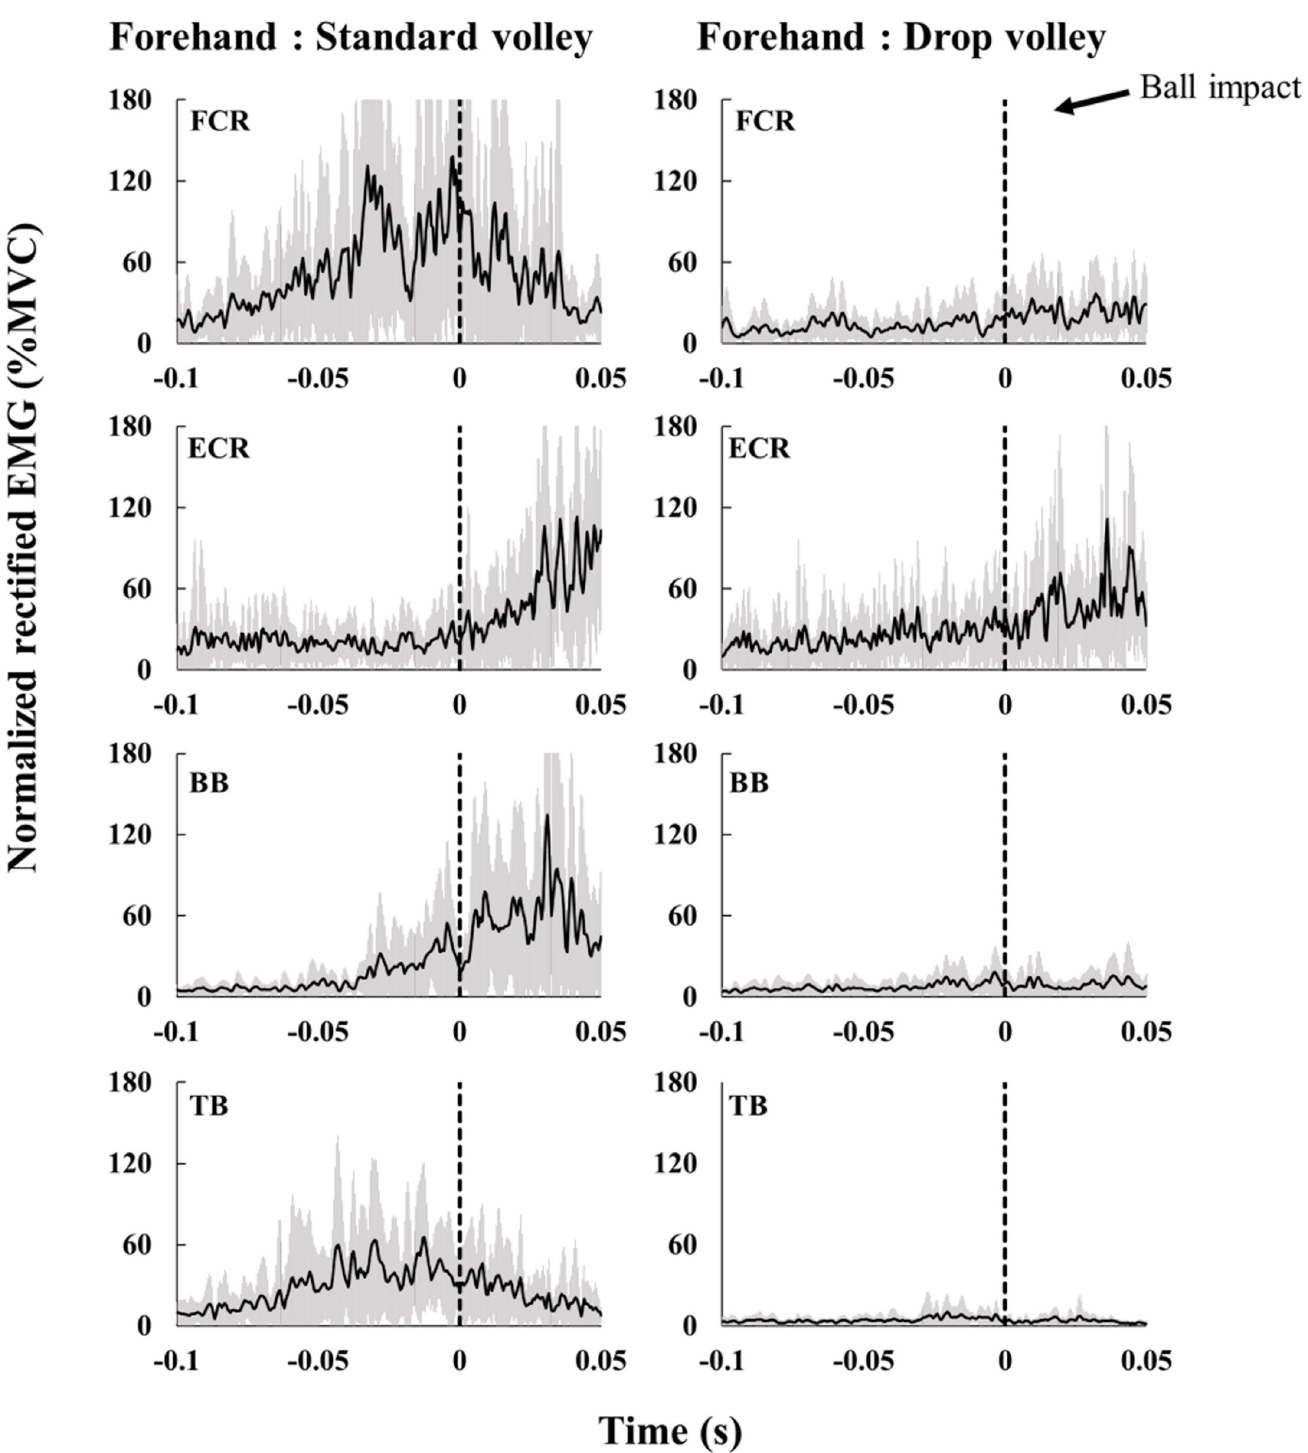
Fig 5. Rectified EMGs of one representative subject for the standard forehand volley (left) and the forehand drop volley (right). Black lines indicate averaged values of all trials, grey areas indicate standard deviation. The dashed line (0 s) denotes the impact.